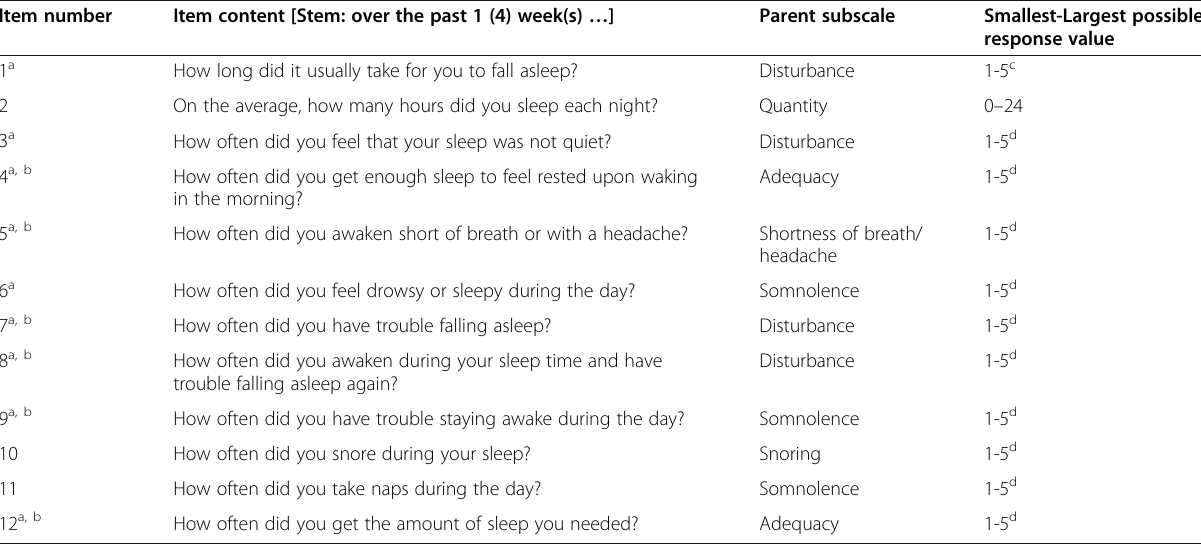
Table 1 MOS Sleep-R